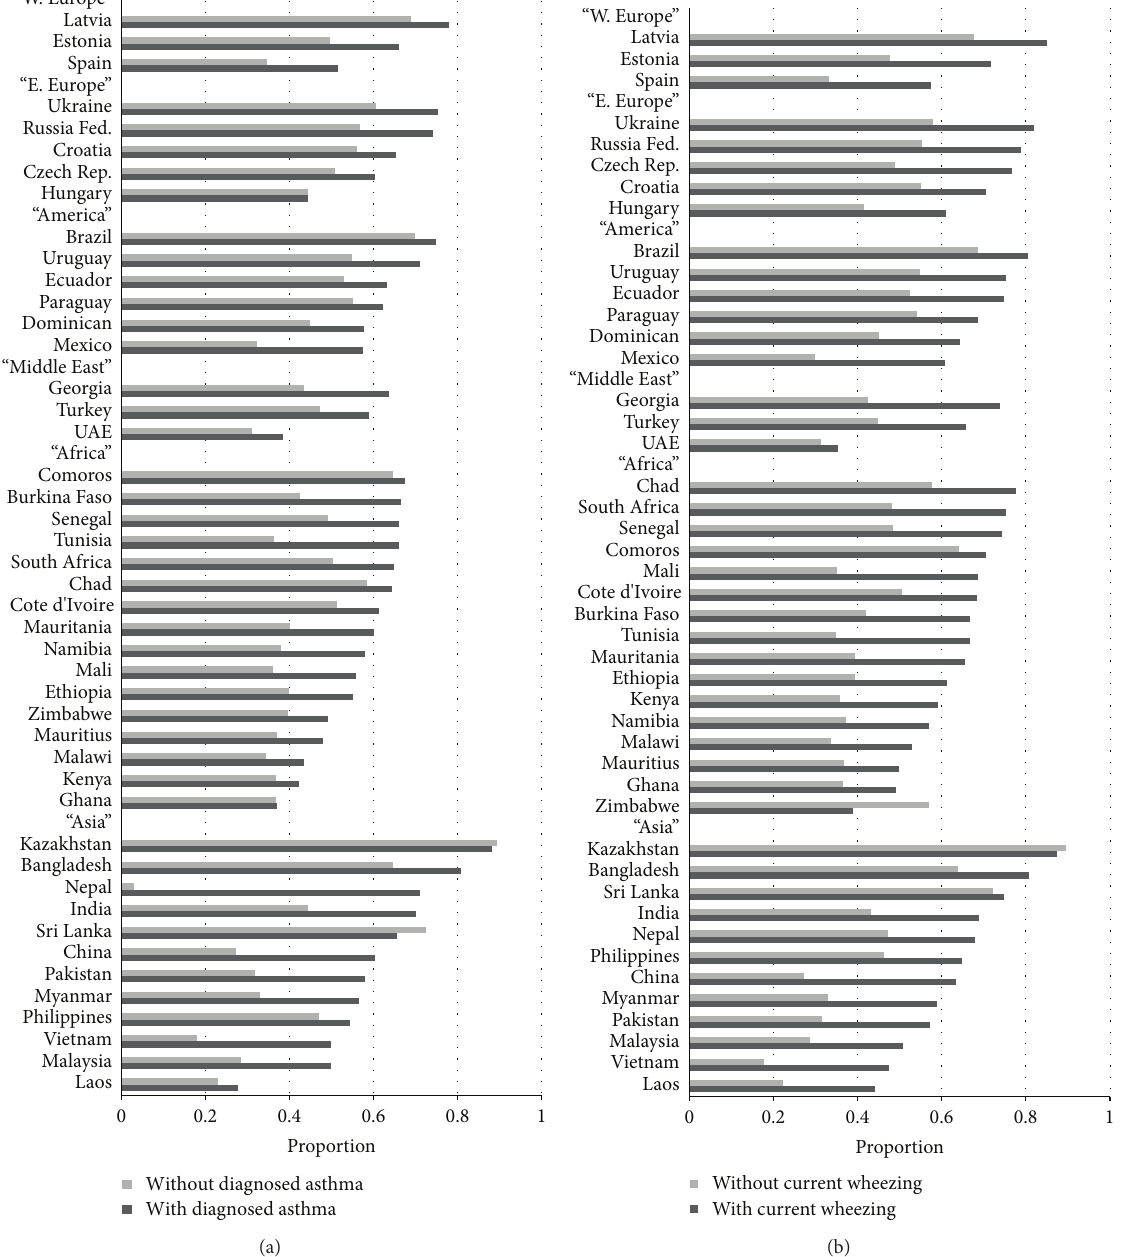
Figure 2: (a) Weighted proportions of 30-day anxiety by diagnosed asthma. (b) Weighted proportions of 30-day anxiety by current wheezing.